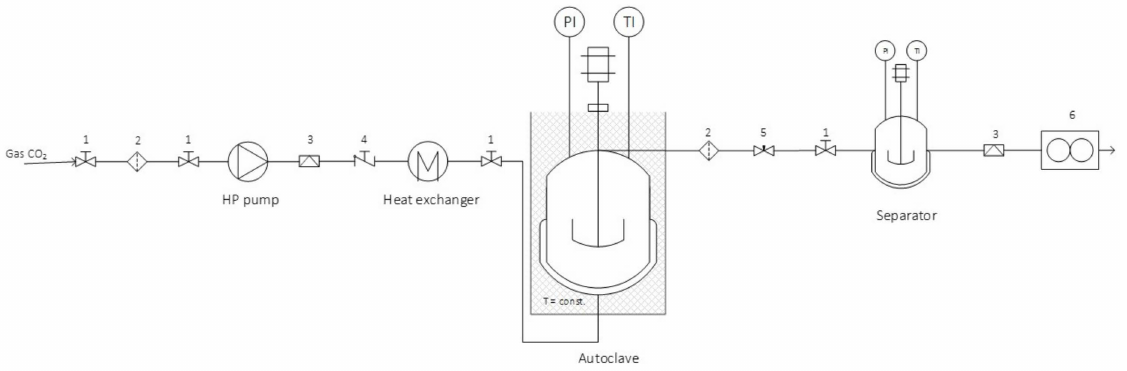
Figure 2. Supercritical fluid extraction system; 1: valve, 2: high pressure filter, 3: rapture disc, 4: one-way valve, 5: regulating valve, 6: gas flowmeter, PI: pressure indicator and